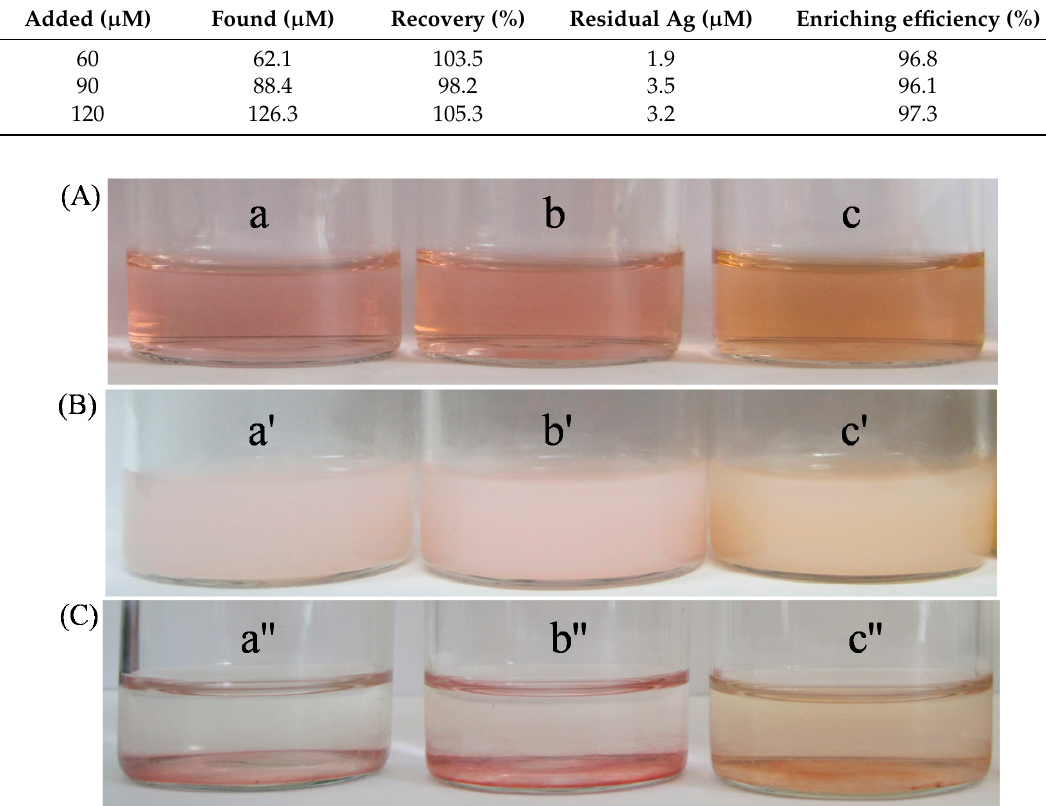
Table 1. Results of the Ag + recovery and separation experiments performed in drinking water